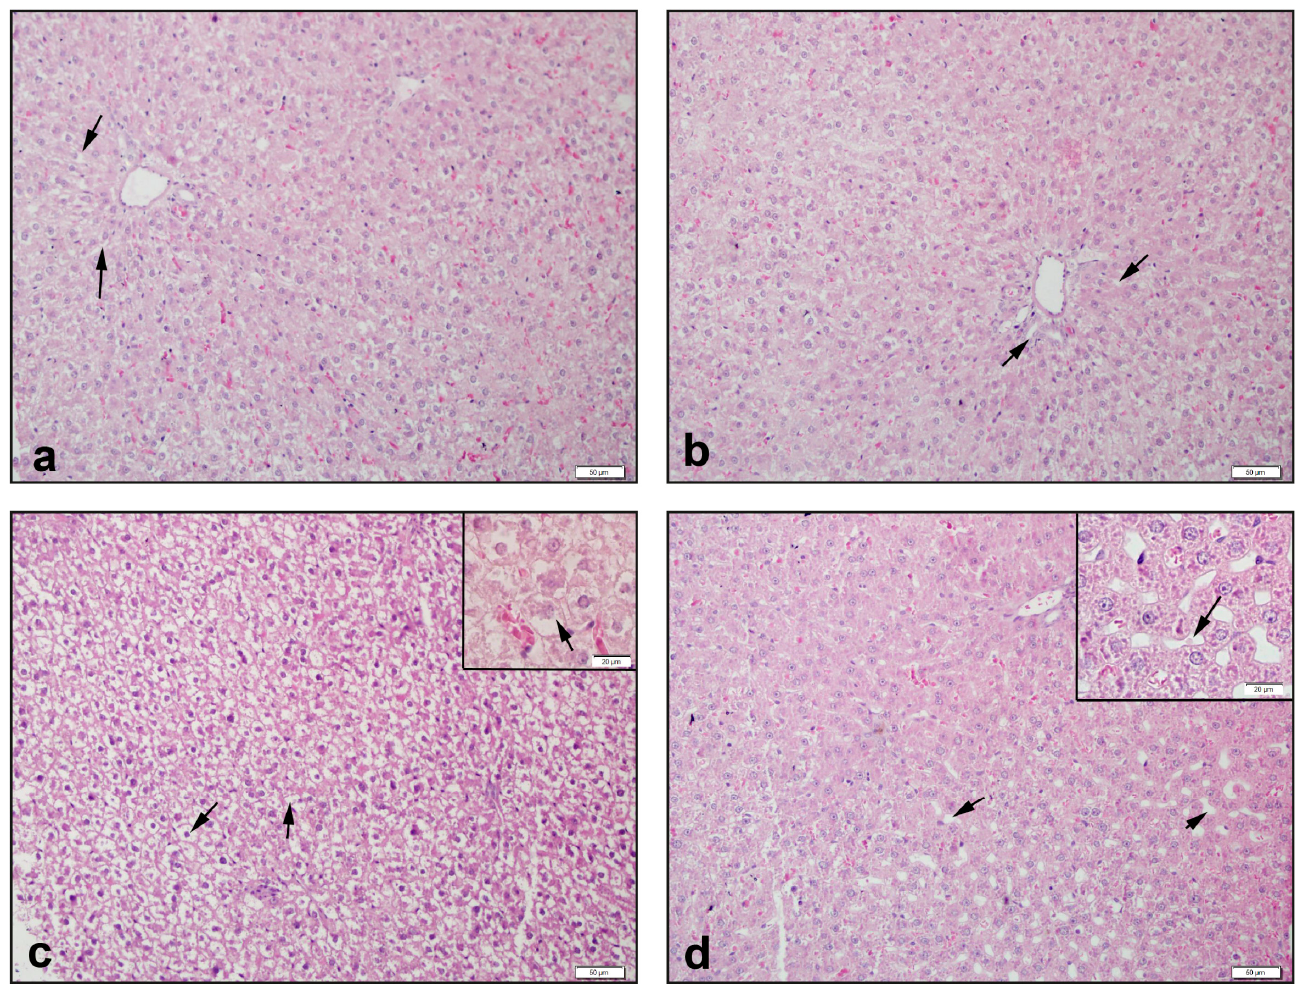
Figure 5. Histological view of liver: ( a ) Control group of → : regular hepatocytes and central vein in the middle; ( b ) NAC group of → : central vein and sinusoids; ( c ) CPT-11 group of → : hepatocytes that are severely enlarged and have lost their cytoplasm; ( d ) CPT-11+NAC group of ‣ : hepatocytes were observed to regenerate, and → : the sinusoids returned to their former structures. Hematoxylin & Eosin staining, 50 μ m scale bar.